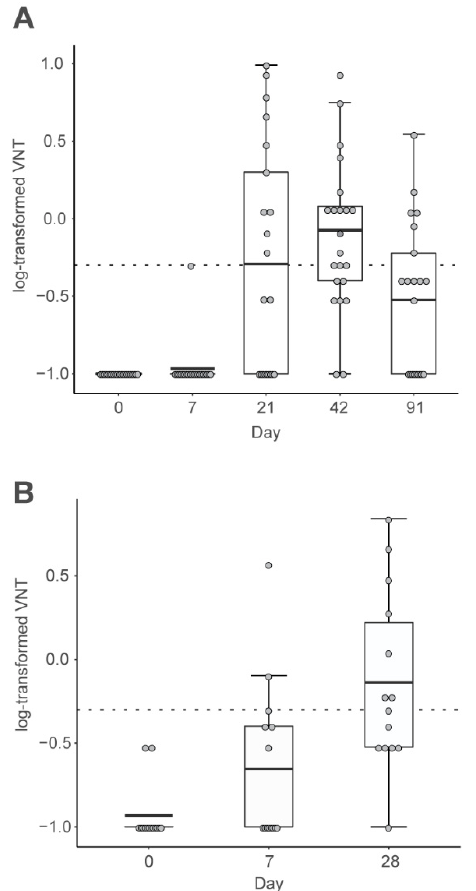
Figure 2. Serum neutralizing antibody responses in human volunteers to intradermal injection of 80 µ g mRNA using a Tropis needleless injector (adapted from reference [34]). ( A ), responses to three primary vaccinations ( n = 21), ( B ), responses to the one-year booster ( n = 14). Each dot represents a participant. Boxes depict geometric mean titers and interquartile ranges (IQRs); whiskers extend from the hinge to the highest or lowest value within 1.5 × IQR of the respective hinge, and the dashed line marks the protective threshold. VNT = virus neutralizing titer.